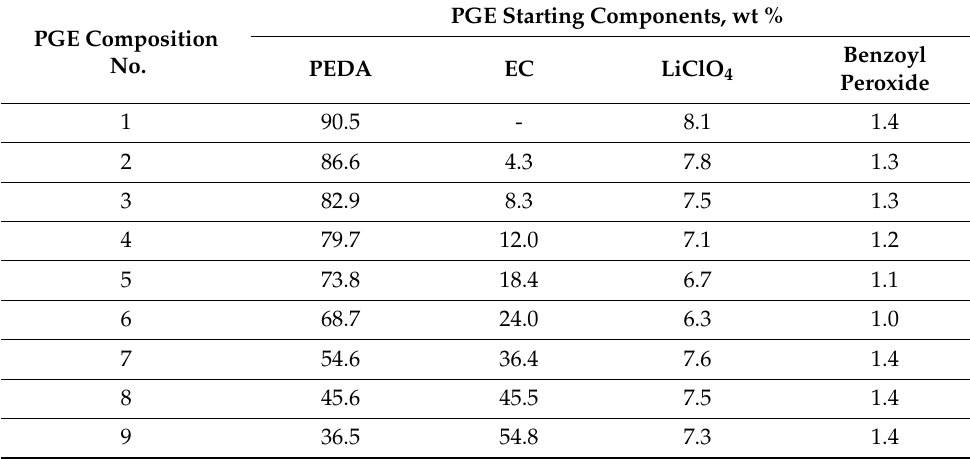
Table 4. Compositions of the polymer